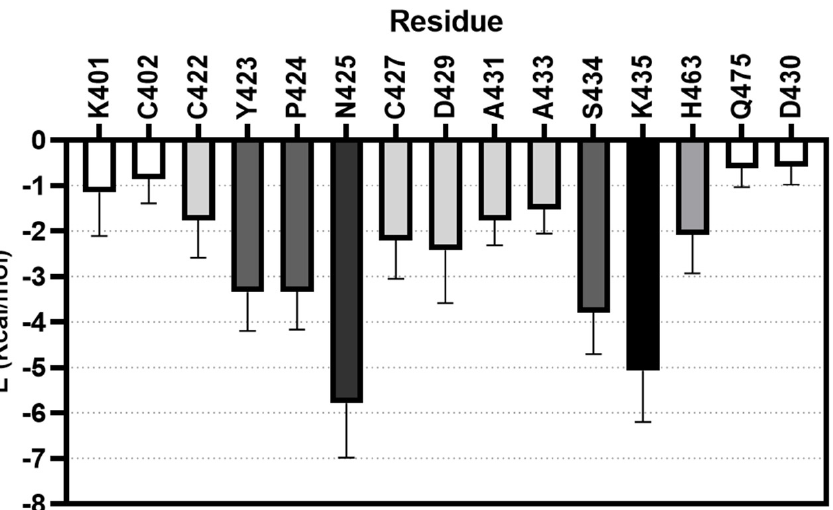
Figure 6. Energy contribution per residue given by MM_ISMSA for the complex nSmase2-DPTIP.